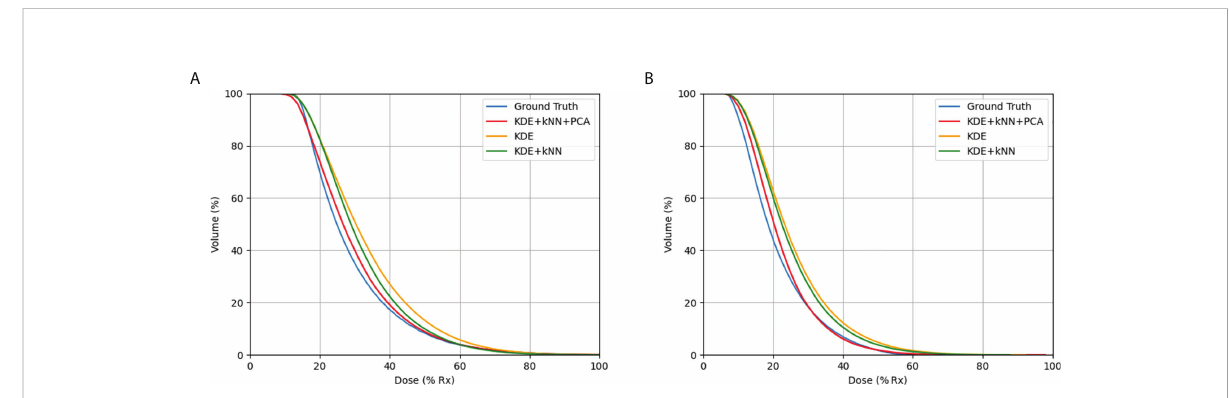
FIGURE 7 Comparison of DVHs in actual plan and the predicted DVHs using different methods: (A) bladder, (B) rectum. The method using KDE, kNN, and PCA produced the most accurate results when compared to actual